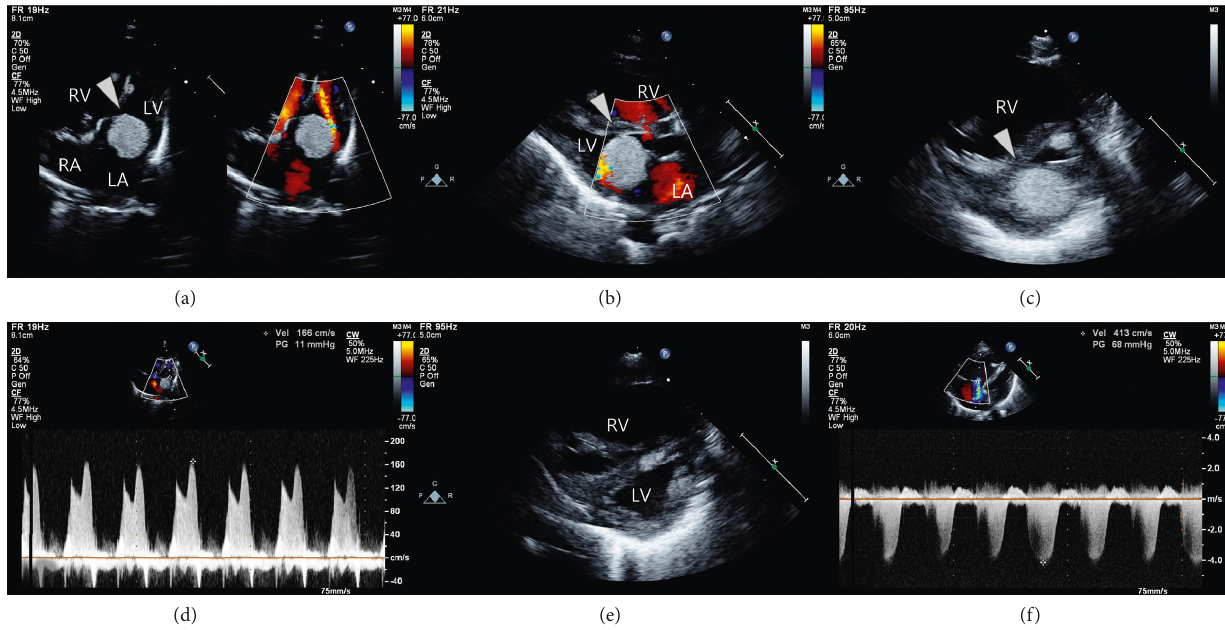
Figure 1: Two-dimensional echocardiography shows a large rhabdomyoma (arrowhead), 20.5 × 15.6mm in diameter, occupying 75–90% of the mitral annulus, in addition to multiple small tubers in both ventricles and the left ventricular outflow tract after birth in apical 4-chamber (a), parasternal long-axis (b), and parasternal short-axis (c) views. Right atrial, right ventricular (RV), and left atrial dilatation were also observed. Pulse Doppler echocardiography showed a peak velocity through the mitral valve of 1.66m/s (d). RV dilatation and pressure overload secondary to pulmonary hypertension were observed in a parasternal, end-diastolic short-axis view (e). The peak velocity through the tricuspid valve was 4.13m/s